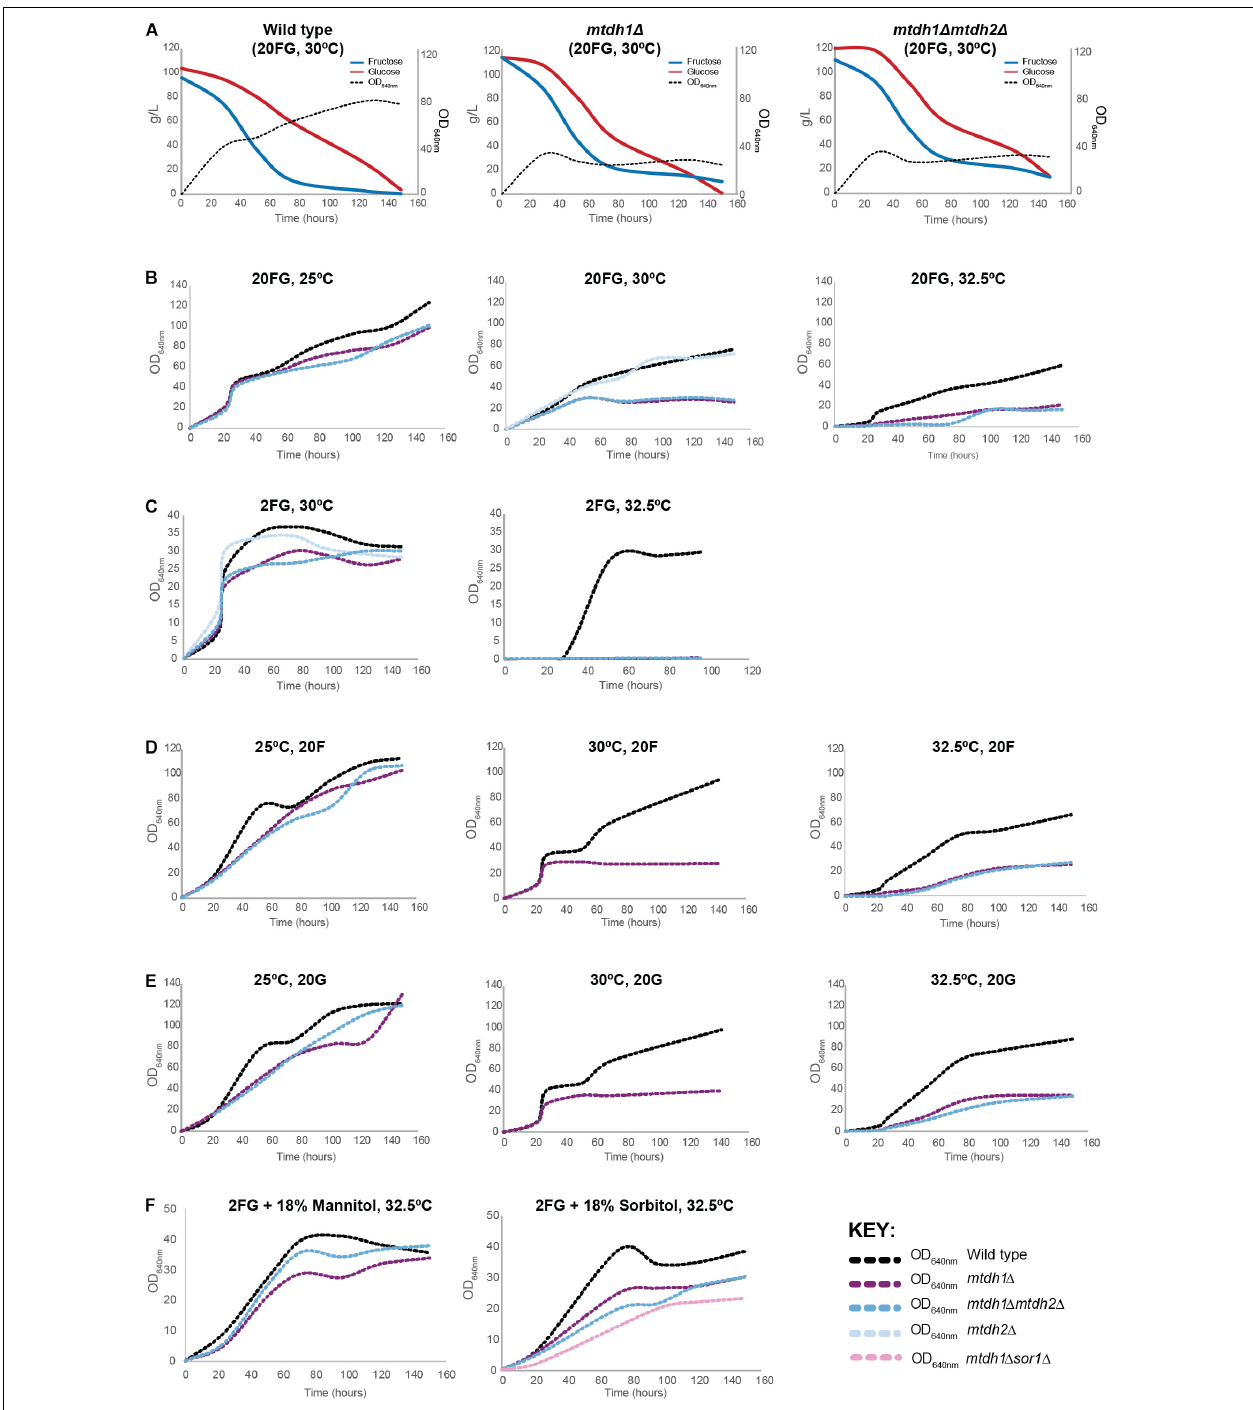
FIGURE 4 | Effect of MtDH deletion on fructophily and on biomass yield at different growth temperatures. (A) Sugar consumption profiles of St. bombicola wild type, mtdh1 (cid:49) and mtdh1 (cid:49) mtdh2 (cid:49) mutants. Strains were cultivated in YP supplemented with 10% (w/v) glucose and 10% (w/v) fructose (20FG) for 150 h at 30 ◦ C. Experiments were performed with two biological replicates. (B) Growth of wild type, mtdh1 (cid:49) , mtdh2 (cid:49) and mtdh1 (cid:49) mtdh2 (cid:49) in YP supplemented with 10% (w/v) glucose and 10% (w/v) fructose (20FG) for 150 h at different temperatures: 25, 30, and 32.5 ◦ C. (C) Growth of St. bombicola wild type, mtdh1 (cid:49) and mtdh1 (cid:49) mtdh2 (cid:49) in YP supplemented with 1% (w/v) glucose and 1% (w/v) fructose (2FG) at 30 and 32.5 ◦ C. (D,E) Growth of St. bombicola wild type, mtdh1 (cid:49) and mtdh1 (cid:49) mtdh2 (cid:49) in YP supplemented with 20% (w/v) fructose (20F) (D) or 20% (w/v) glucose (20G) (E) for 150 h at 25, 30, and 32.5 ◦ C. (F) Growth of St. bombicola wild type, mtdh1 (cid:49) , mtdh1 (cid:49) mtdh2 (cid:49) in (2FG) supplemented with 18% (w/v) mannitol (left) or 18% (w/v) sorbitol (right) at 32.5 ◦ C. St. bombicola mtdh1 (cid:49) sor1 (cid:49) was only grown in 2FG supplemented with 18% (w/v) sorbitol. Raw data can be found in Supplementary Data S1 .